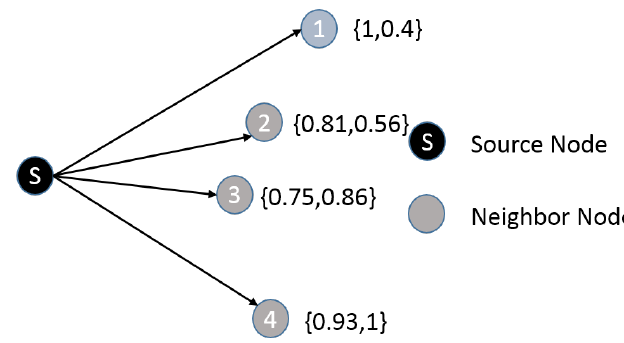
Figure 7. Two parameters of